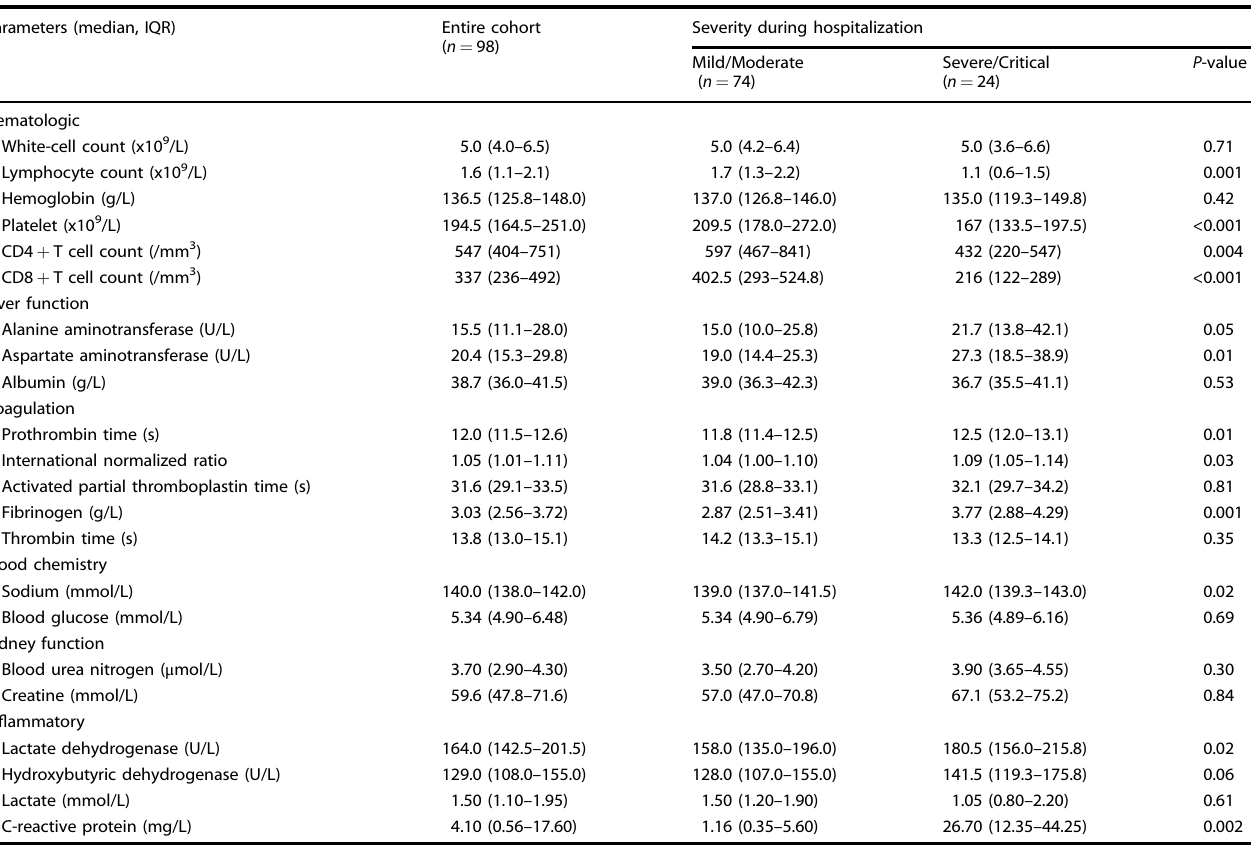
Table 3. Laboratory results of patients with COVID-19 on admission by severity during